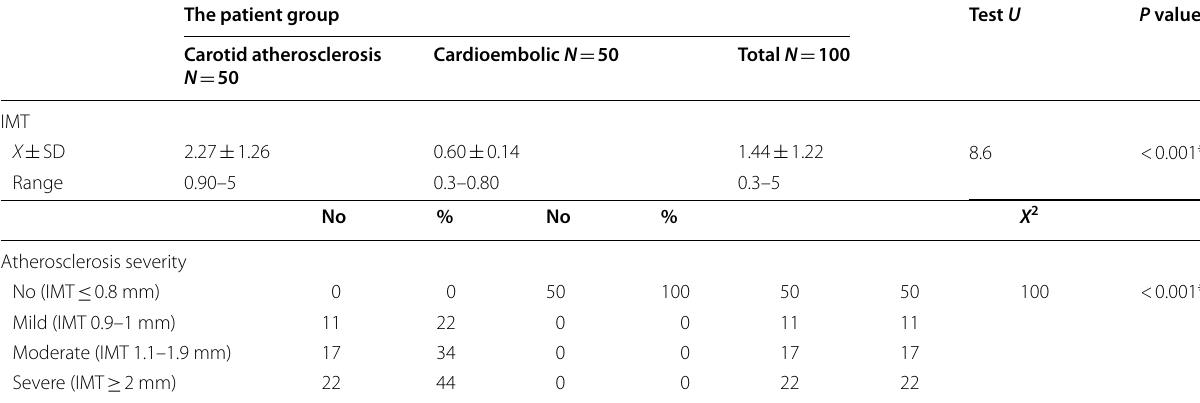
Table 3 Carotid intima–media thickness (IMT) among atherosclerotic and cardioembolic groups